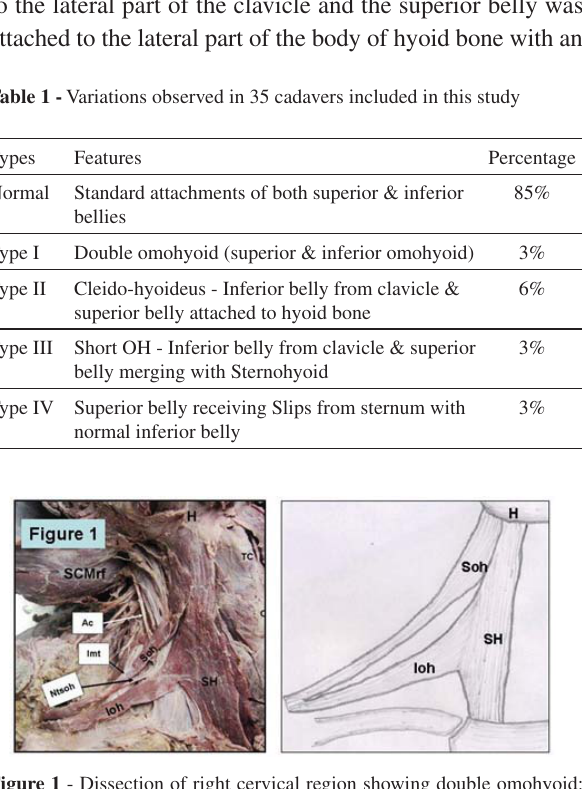
Figure 1 - Dissection of right cervical region showing double omohyoid: SH - Sternohyoid; Ioh - Inferior belly of Omohyoid; Soh - Superior belly of Omohyoid; H - hyoid bone